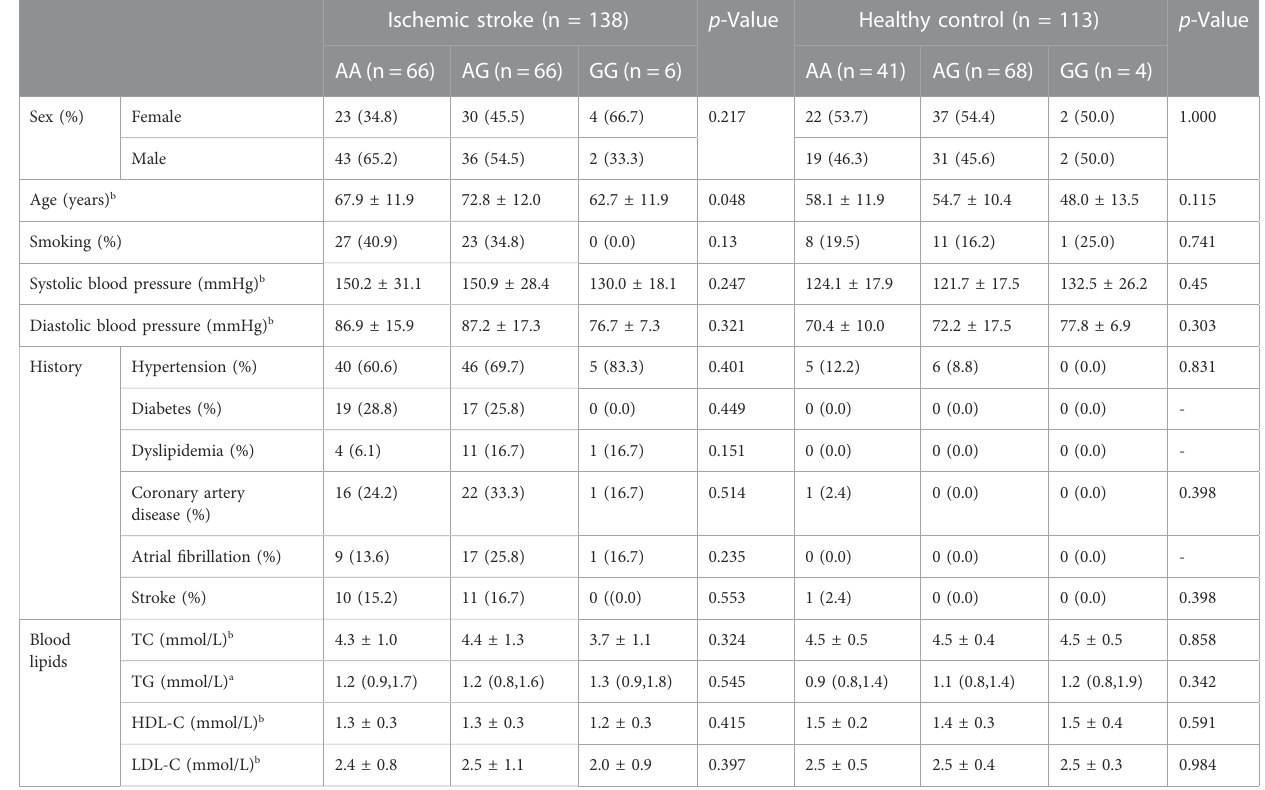
TABLE 5 Association between different FABP1 genotype and risk factors for ischemic stroke.